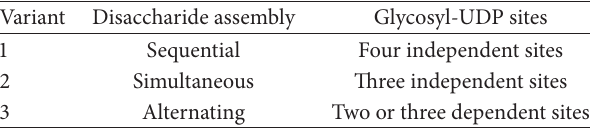
Table 1: Three variations of the Pendulum